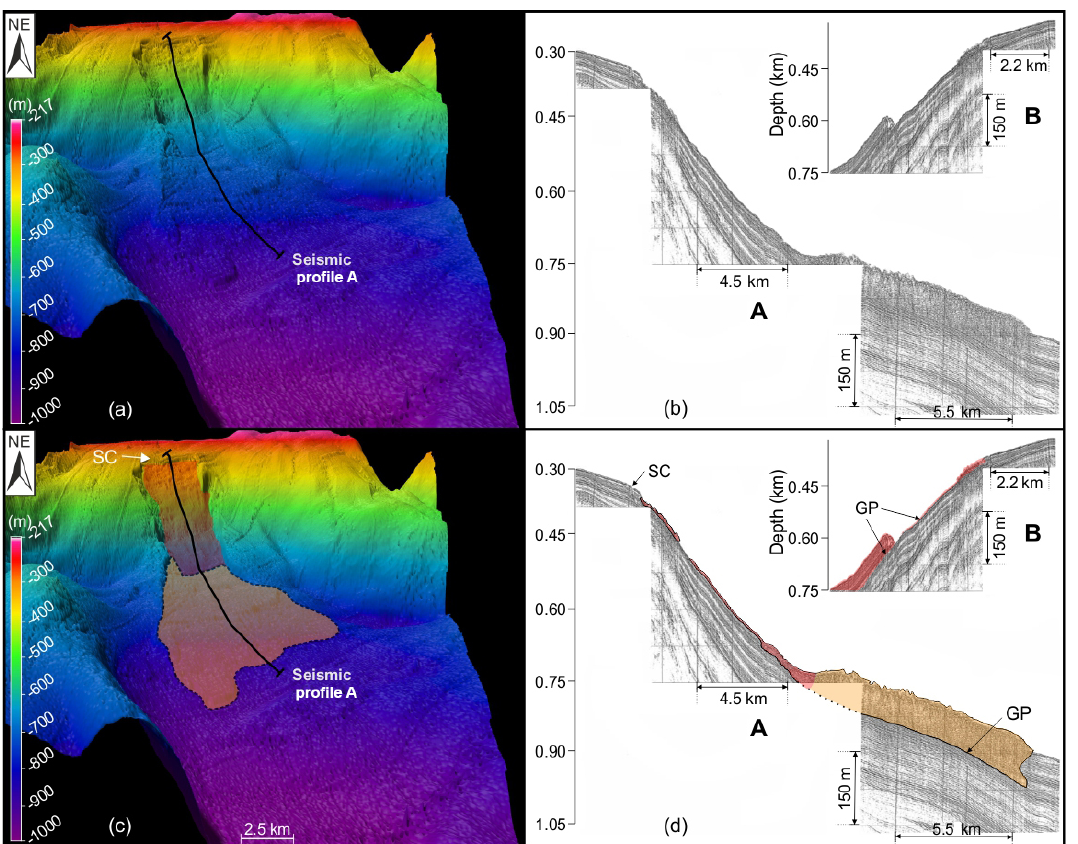
Figure 2. Features of the Thasos submarine landslide. In red is the first unit, in orange is the second unit. (a) 3-D view of the actual bathymetry of the Thasos landslide. (b) Raw seismic profiles from Lykousis et al. (2002): (A) downslope air-gun sub-bottom profile indicated on (a) and (B) details of the seismic profile along the major glide zone. (c) Interpretation of the 3-D bathymetry: in red is the area in which the deposit is thin or non-existent in the upper part of the slide; in orange is the area where the deposit is thick (marked on the bathymetry by a hummocky facies and in the seismic profile by chaotic and hyperbolic reflectors); SC is slide scarp. (d) Interpretation of seismic profiles with the same convention as in (c) , GP is the glide plane. Panels (b) and (d) are modified after Lykousis et al.